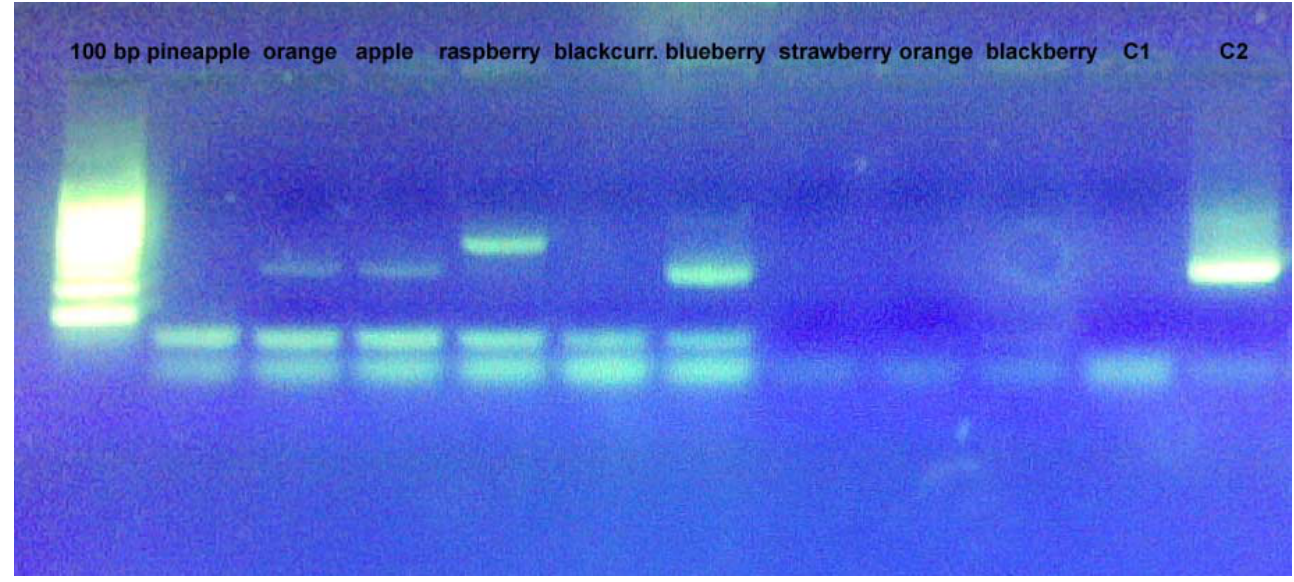
Figure 2. Amplification profile of some DNA samples extracted from “home–made” fruit juices observed with PI and PII